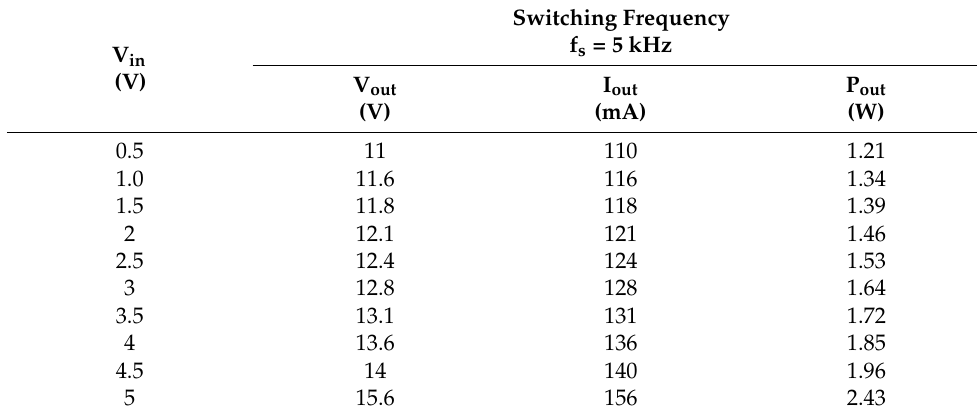
Table 15. Output voltage, current and power at f s = 5